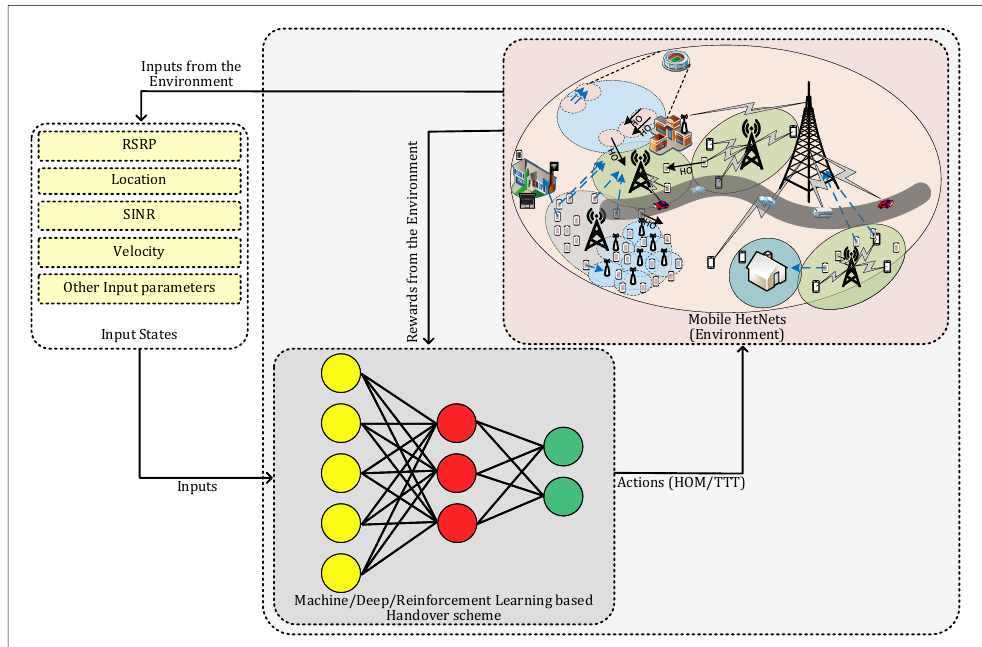
Figure 10. Schemetic Diagram of Machine Learning/Deep Learning-based Handovers in